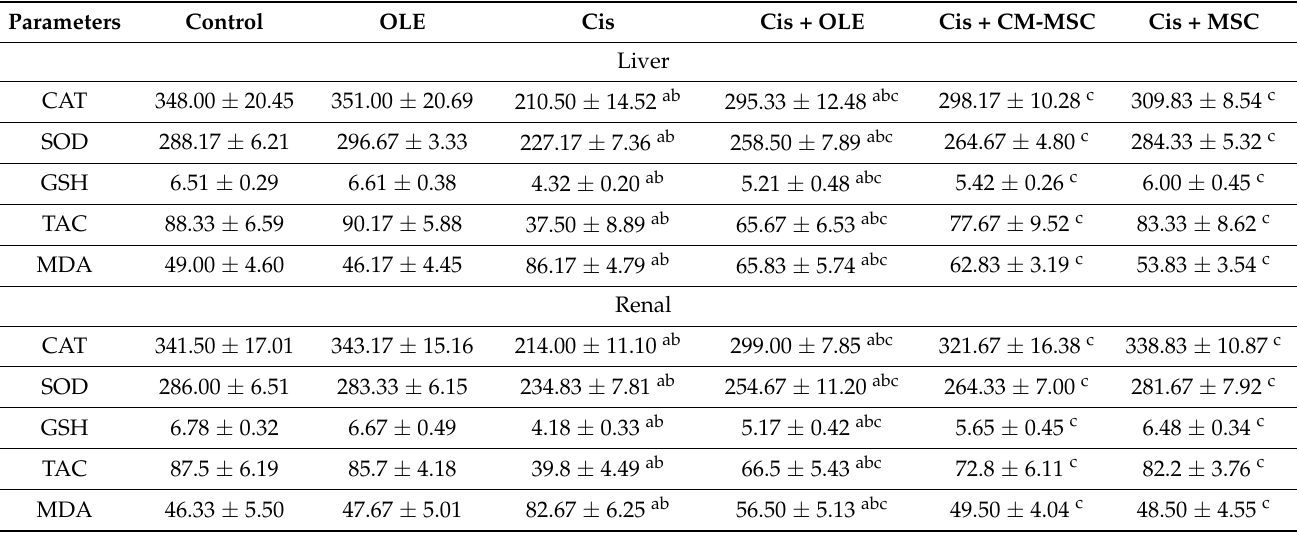
Table 4. Effects of olive leaf extract (OLE), mesenchymal stem cells (MSC), CM-MSC, cisplatin, and their combination on liver and renal oxidative markers of rats.